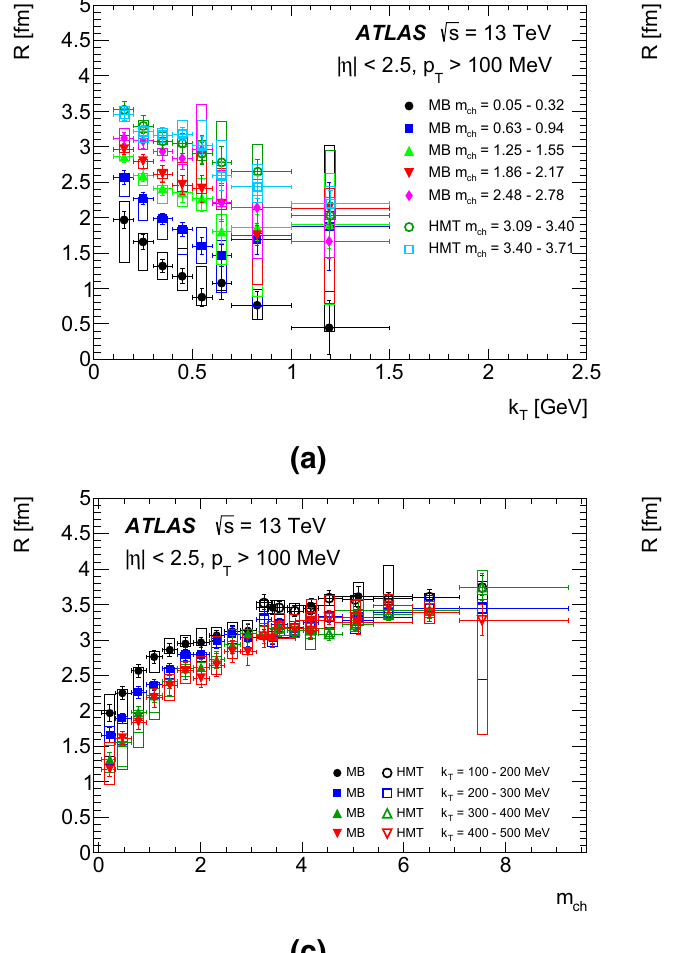
and d as a function of m ch in k T intervals between 0.5 and 1.5 GeV. The error bars and boxes represent the statistical and systematic contribu- tions,